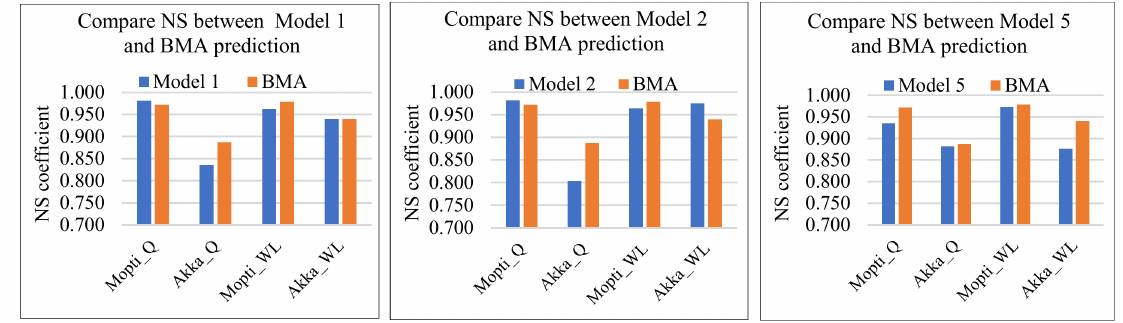
Figure 10. Comparison of NS coe ffi cient of BMA to each of Models 1,2, and